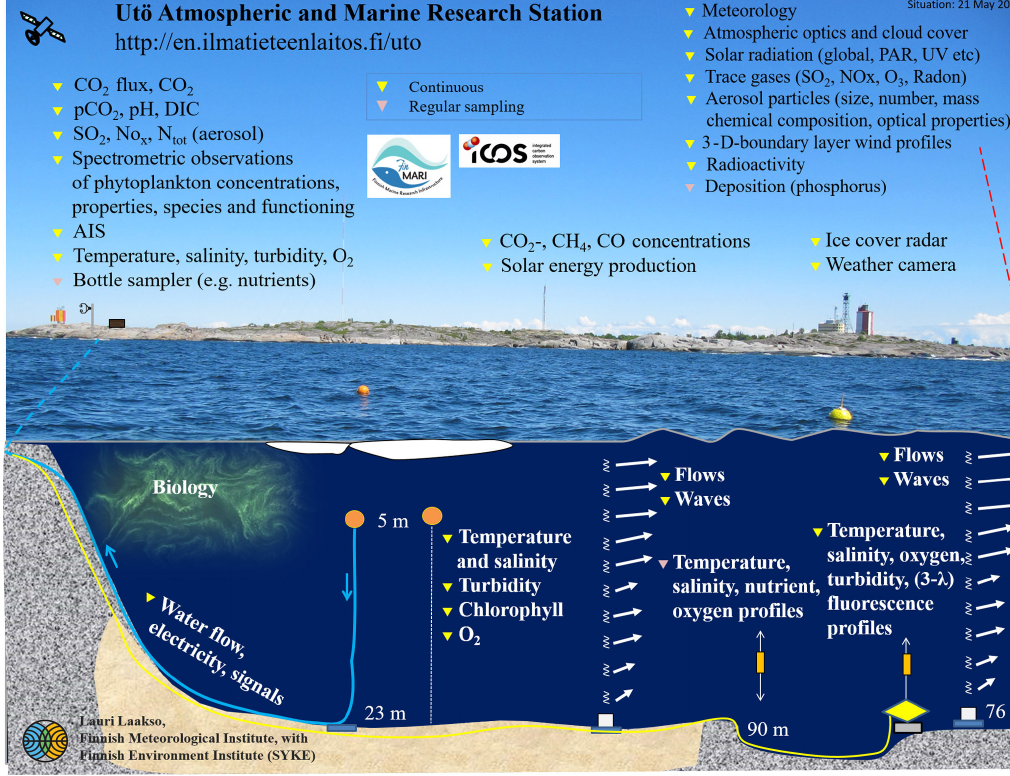
Figure A2. A schematic picture showing the observations at Utö. For a list of current observations, please see Table